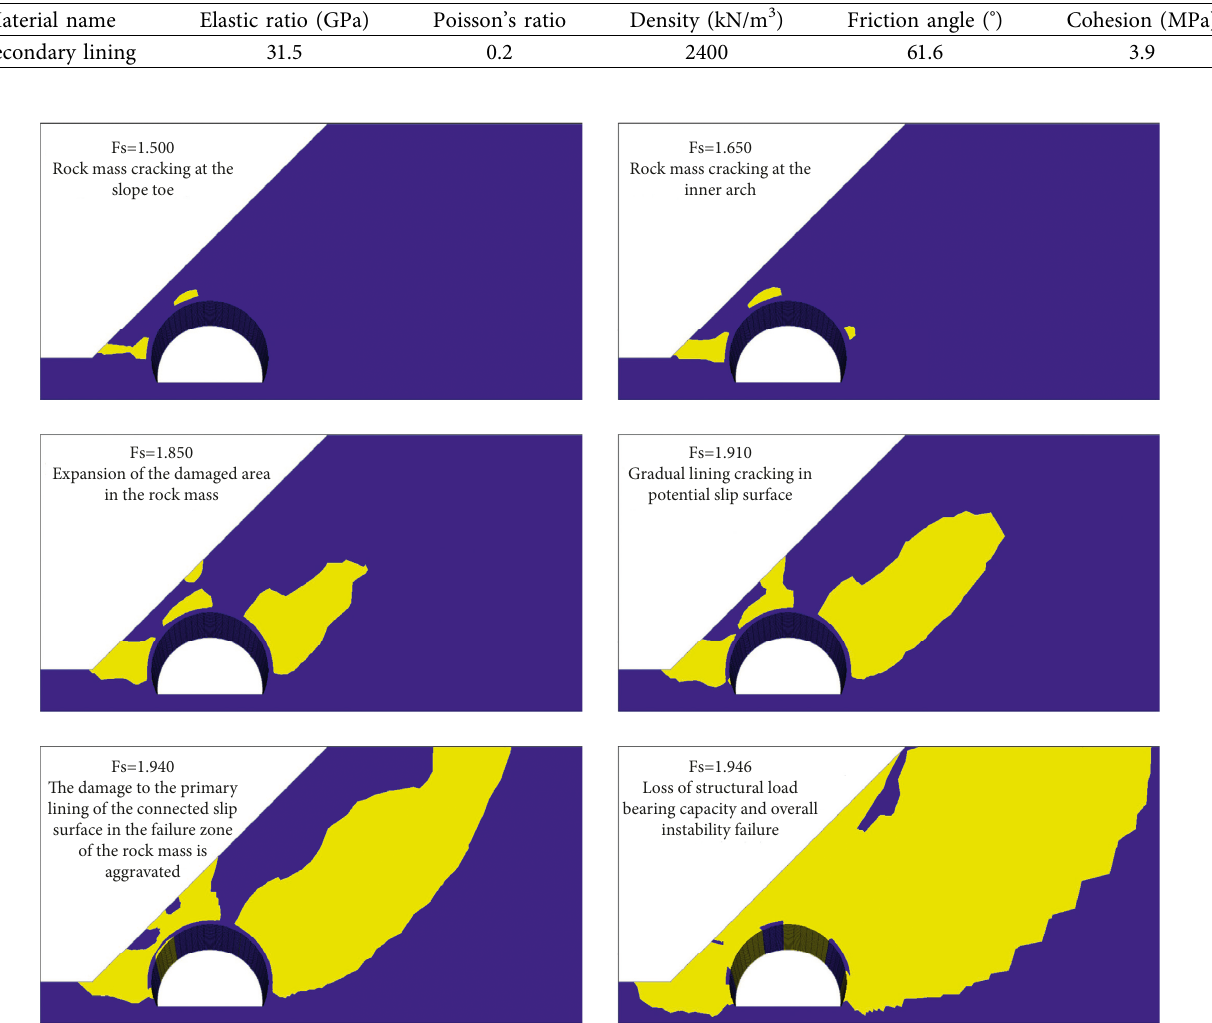
Figure 8: Ultimate strain cloud diagram of surrounding rock under different reduction